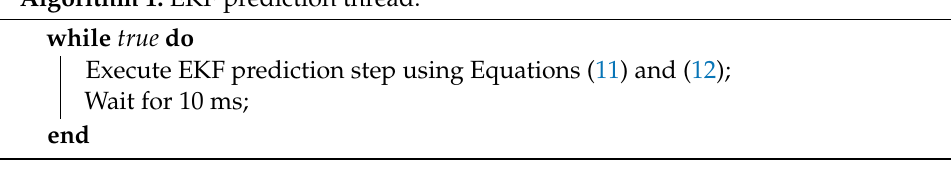
Algorithm 2: Total station